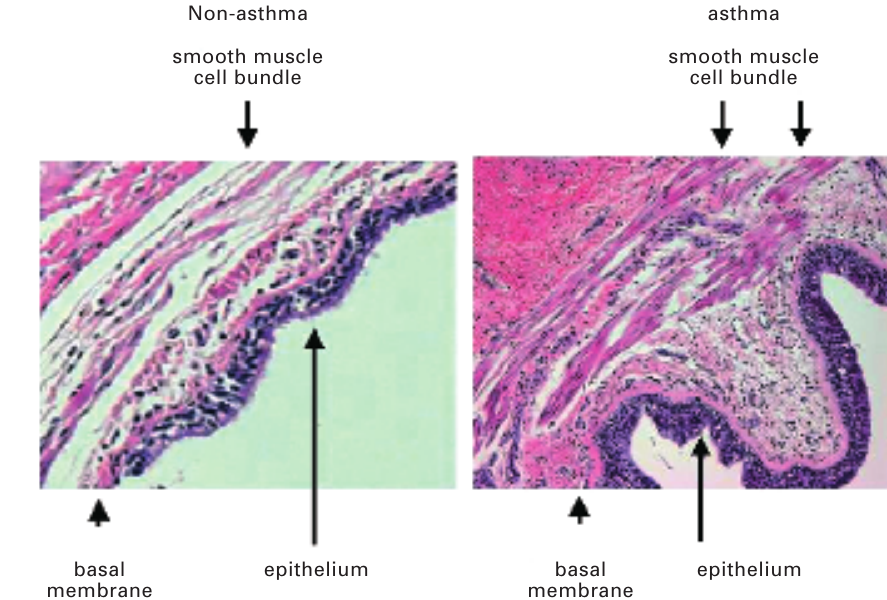
Figure 1 Histology of the non-asthmatic (left panel) and the asthmatic (right panel) airway wall. In the non-asthmatic airway the bundles of smooth muscle cells is thin and consists of a few cells only, while in the asthmatic airway wall the number of muscle bundles as well as the number of smooth muscle cells per bundle increases markedly. The basement membrane in the non-asthmatic airway is a think layer separating the epithelial cell layer from a thin layer of connective tissue formed by extra- cellular matrix and fibroblast like cells (myo- fibroblasts). In contrast in the asthmatic airway the basement membrane is significantly thick- ened as is the mass of the connective tissue